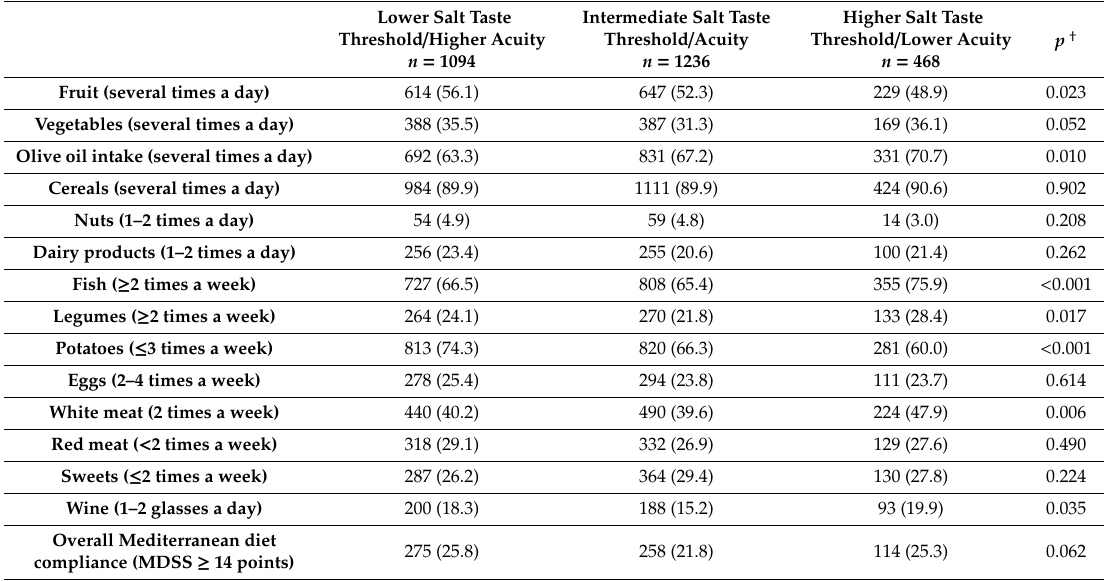
Table A3. Mediterranean diet and food groups consumption based on the modern Mediterranean pyramid [35] according to the salt taste recognition threshold perception, data are presented as n